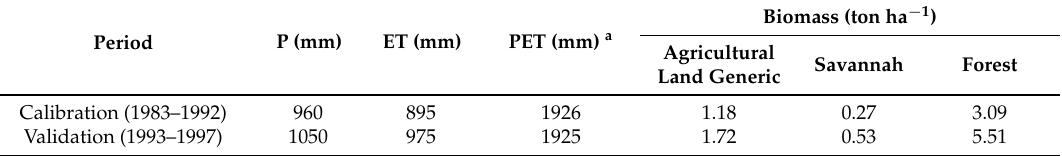
Table 4. Average annual basin values of precipitation (P), evapotranspiration (ET), potential evapotranspiration (PET), and biomass as SWAT outputs on the Bani